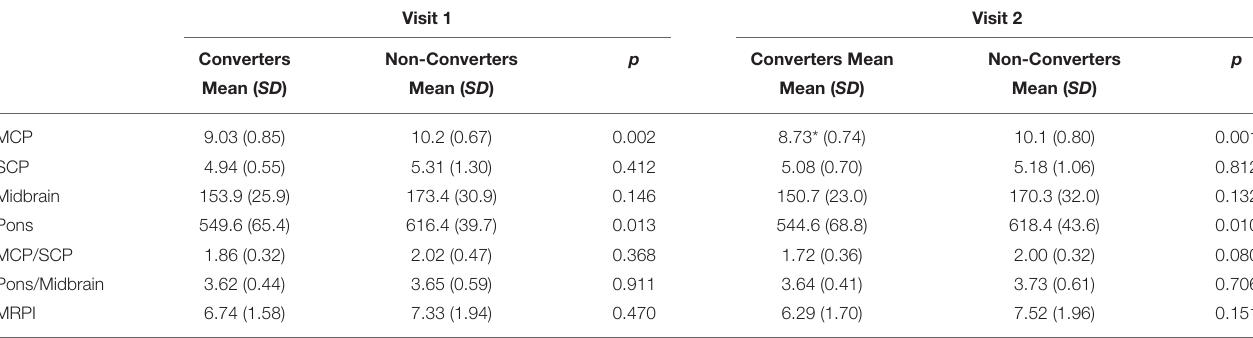
TABLE 4 | Demographics, summarized statistics (mean and standard deviations) and comparisons ( p value) between premutation carrier converters and non-converters . Visit